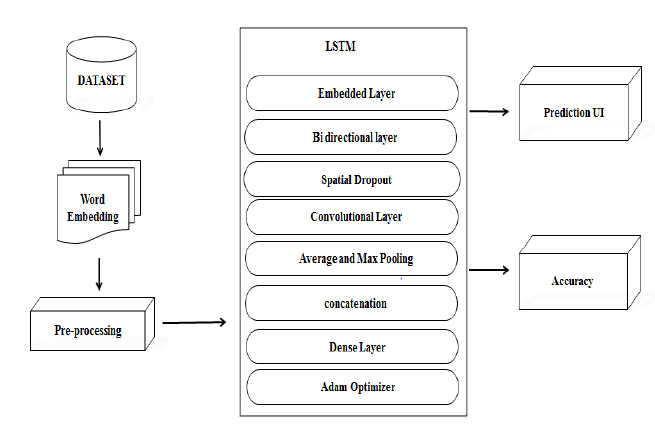
Fig.3 . Long Short Term Memory (LSTM) and its Hidden